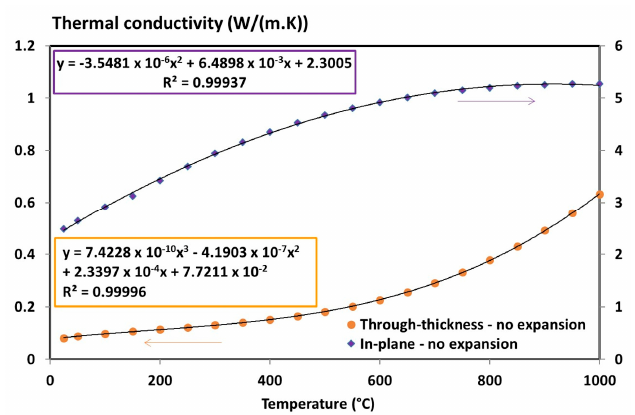
Figure 11. Through-thickness and in-plane thermal conductivity of the degraded T700/M21 composite as a function of the temperature [6].